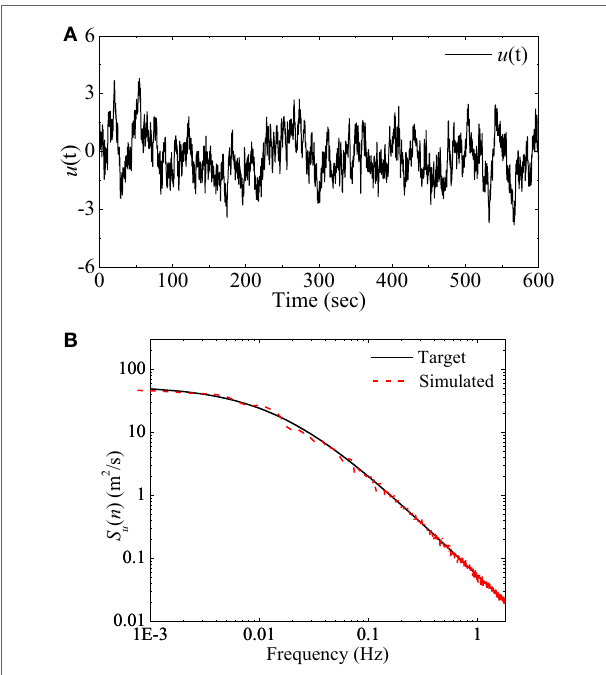
FigUre 3 | simulated lateral wind turbulence . (a) Turbulence time history [ u ( t ): m/s]. (B) Simulated and target